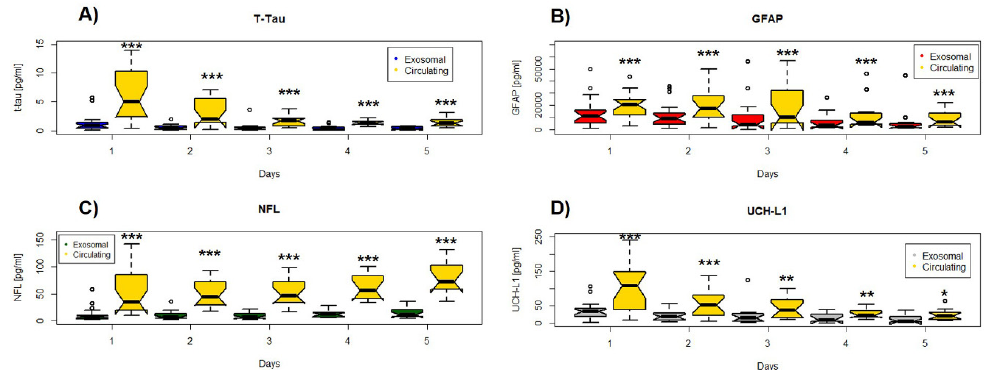
Figure 2. Box and whisker plots of the median concentrations of serum and exosomal and circulating ( A ) t-tau, ( B ) GFAP, ( C ) NFL, and ( D ) UCH-L1 over time of the study. The upper and lower bounds of each box indicate the 75th and 25th percentiles, respectively. Within each box, the horizontal line indicates the median. Whiskers extend to 1.5 × IQR. Significant differences are indicated with * p < 0.05, ** p < 0.01, *** p < 0.001. Cells 2020 , 9 , x